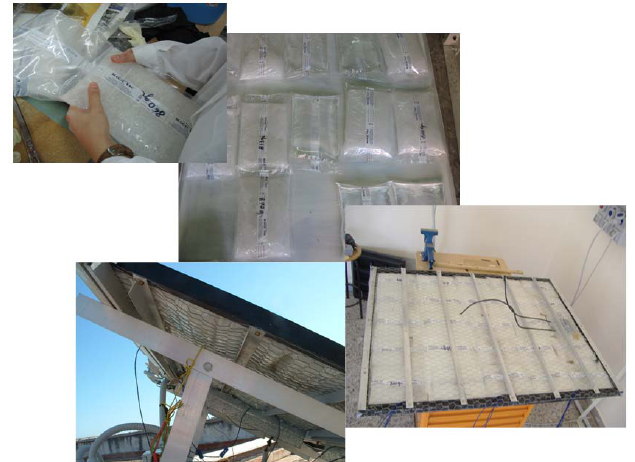
Figure 7. The encapsulated PCM and its